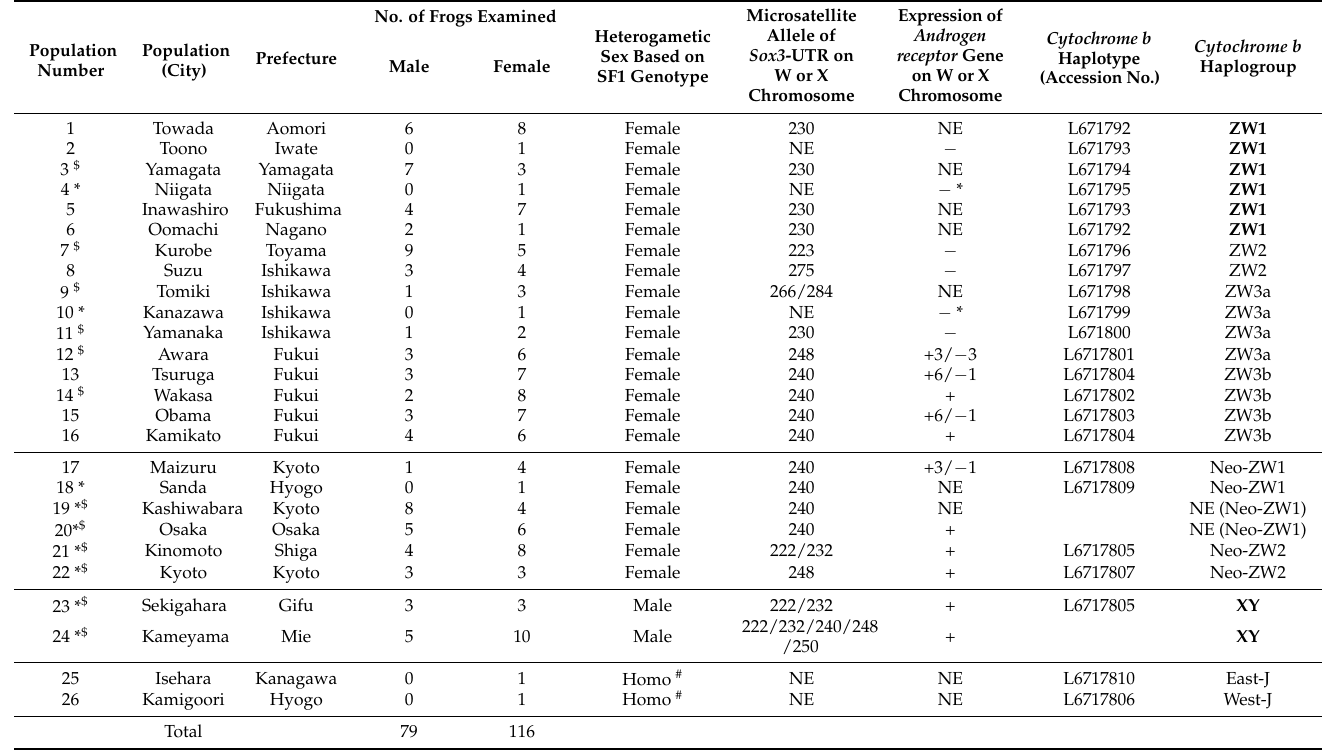
Table 1. Sex-linked genotypes and mitochondrial haplogroups in 24 populations of ZW, Neo-ZW and XY groups and 2 populations of East-Japan and West-Japan